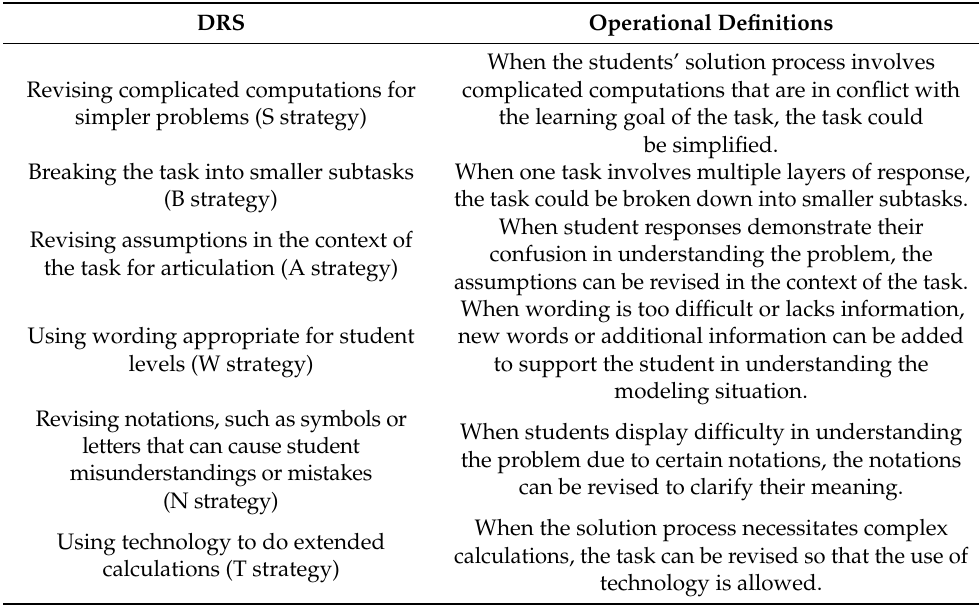
Table 1. Framework for DRS in Analyzing Mathematical Modeling